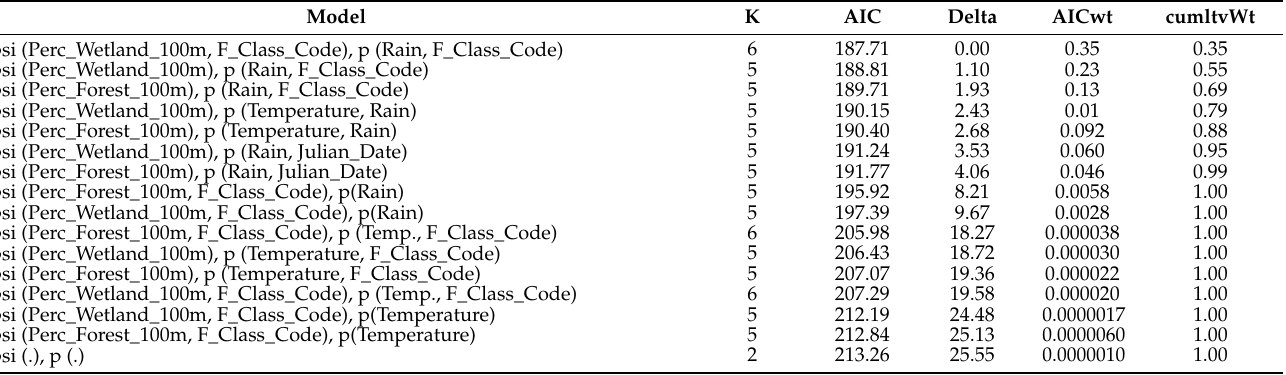
Table A2. Akaike’s Information Criterion (AIC) table for all occupancy models ranked by AIC score, which shows the relationship between large roadkill events and measured covariates in Rhode Island, USA, 2019–2021; psi is occupancy parameter, p is detection parameter, Delta is the Delta AIC, AICwt model